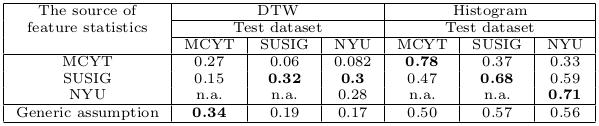
Table from the paper: Distinctiveness, complexity, and repeatability of online signature templates
Table text:
Thesourceof
DTW
Histogram
featurestatistics
Testdataset
Testdataset
MCYT
SUSIG
NYU
MCYT
SUSIG
NYU
MCYT
0.27
0.06
0.082
0.78
0.37
0.33
SUSIG
0.15
0.32
0.3
0.47
0.68
0.59
NYU
n.a.
n.a.
0.28
n.a.
n.a.
0.71
Genericassumption
0.34
0.19
0.17
0.50
0.57
0.56